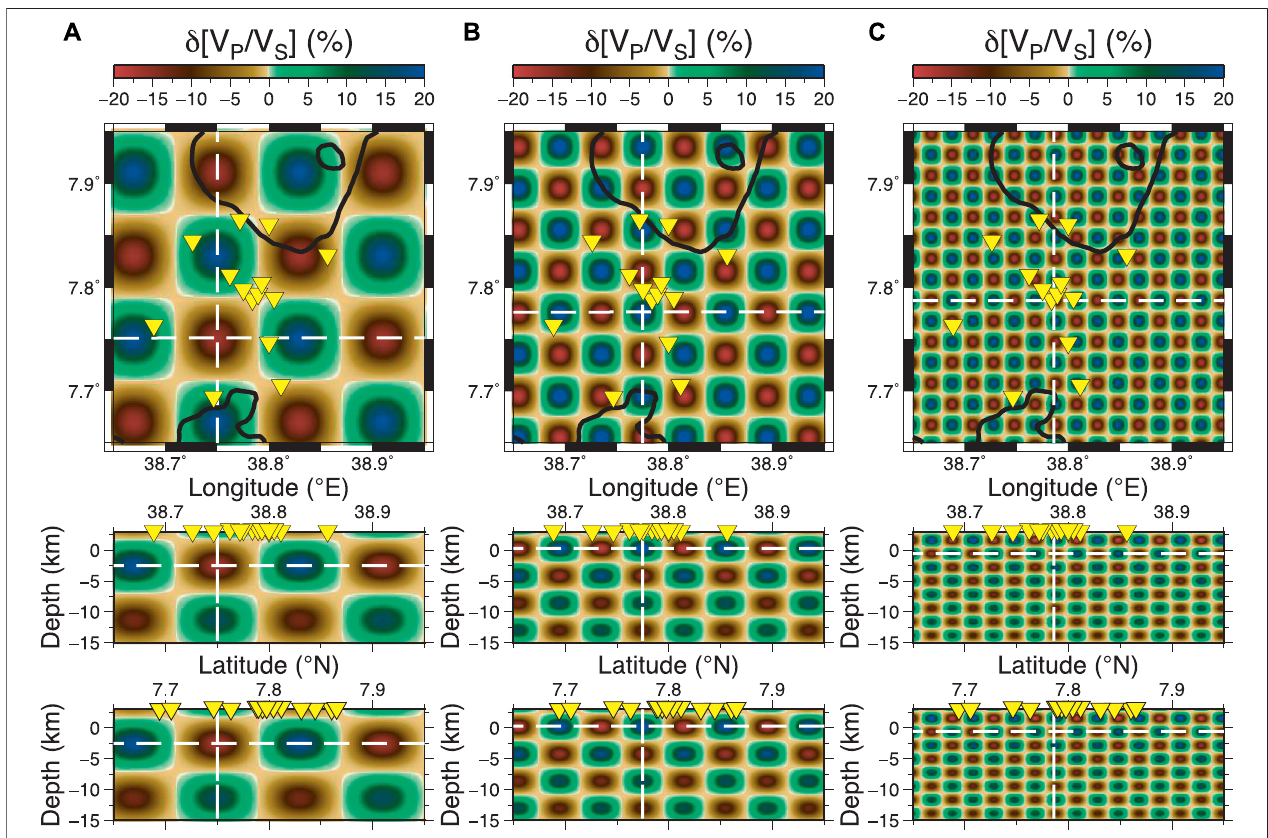
FIGURE3| Input V P / V S checkerboardmodels forresolutiontesting. Slicesaretakenthrough themaximum perturbations of (A) coarse ( ∼ 8.8 km), (B) intermediate ( ∼ 4.4 km) and (C) fi ne checkerboards ( ∼ 2.2 km), to constrain the resolving power at differing scale lengths.